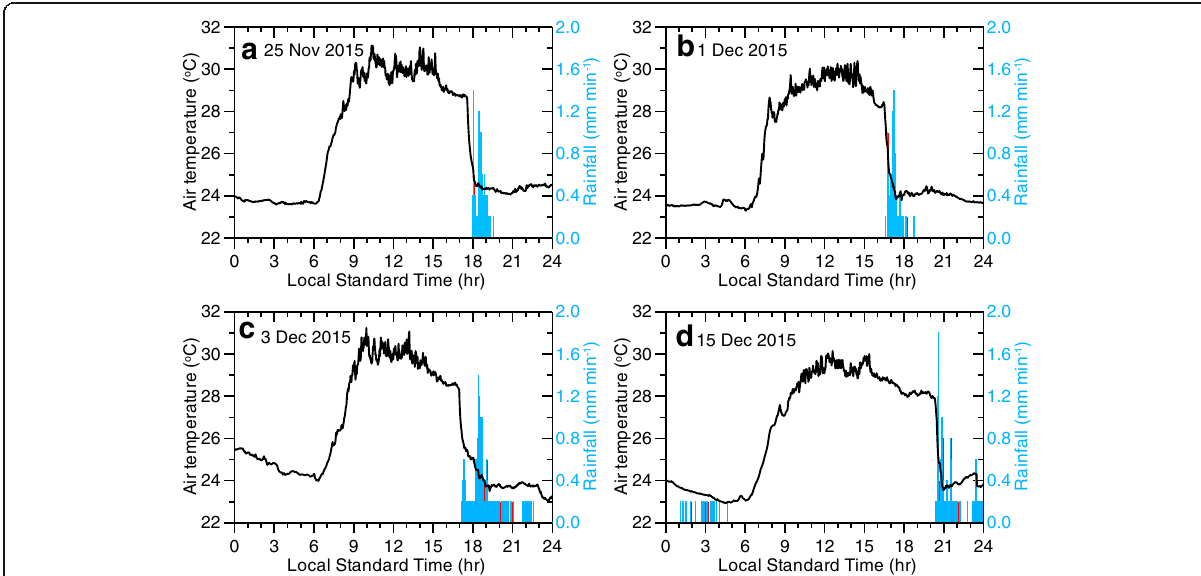
Fig. 3 Time series of surface air temperature and precipitation observed at Bengkulu Meteorological Observatory on Sumatra Island for a ) 25 November, b ) 1, c ) 3 and d ) 15 December 2015 at intervals of 1